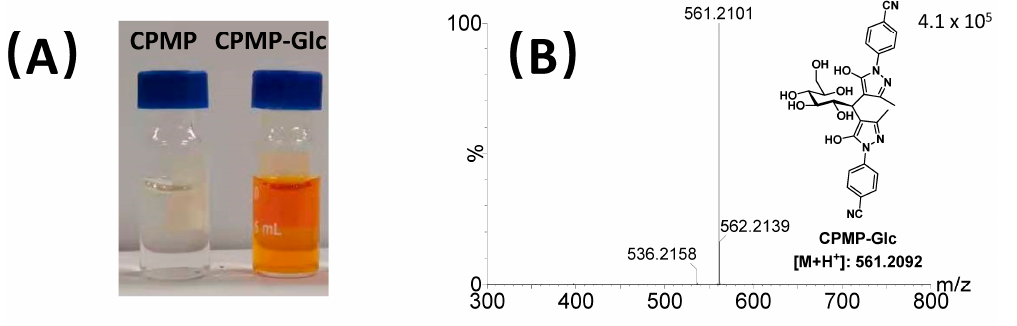
Figure 3. Mechanism analysis: ( A ) Photograph of CPMP and CPMP-Glc solutions; ( B ) HRMS data of CPMP-Glc.